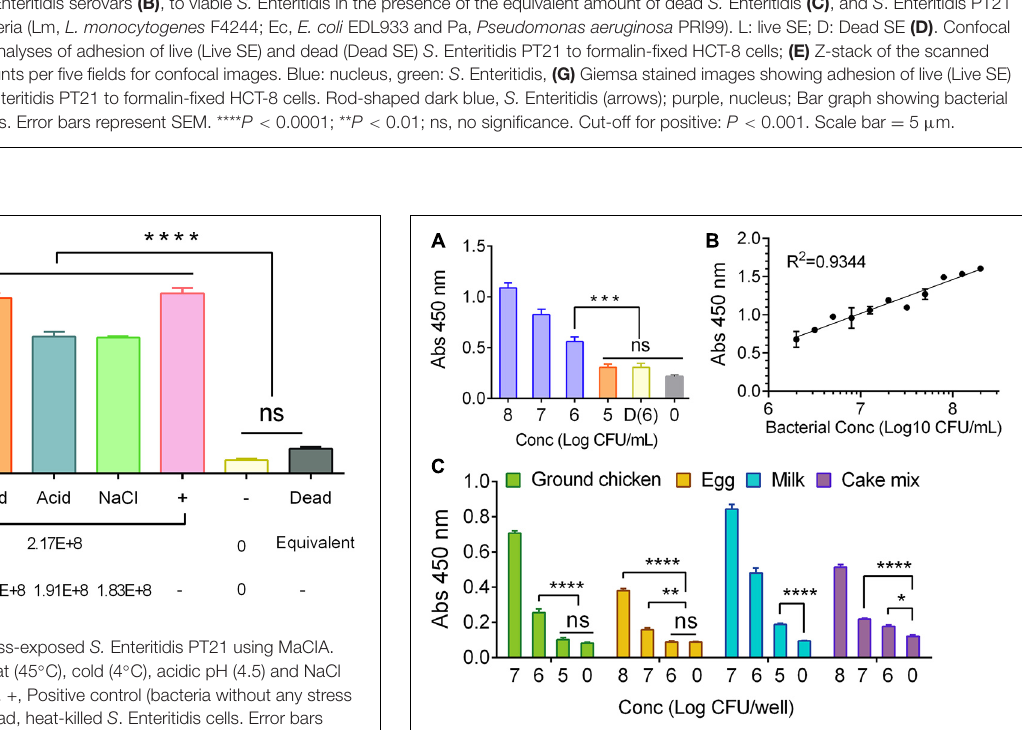
FIGURE 4 | Assay sensitivity for MaCIA. (A) Analysis of limit of detection (LOD) of MaCIA against S. Enteritidis PT21 at 1 × 10 5 CFU/mL to 1 × 10 8 CFU/ml suspended in PBS; and (B) corresponding correlation coefficient of absorbance and bacterial concentration. (C) Analyses of LOD of MaCIA when S. Enteritidis PT21 was suspended in different food matrices. 0, no bacteria; D(6), dead S. Enteritidis PT21 at 1 × 10 6 cells/ml. In all figures, samples with higher concentrations were also significantly ( P < 0.001) different than the dead samples and negative control. Error bars represent SEM. **** P < 0.0001; *** P < 0.001; ** P < 0.01; * P < 0.05; ns, no significance. Cut-off for positive: P <